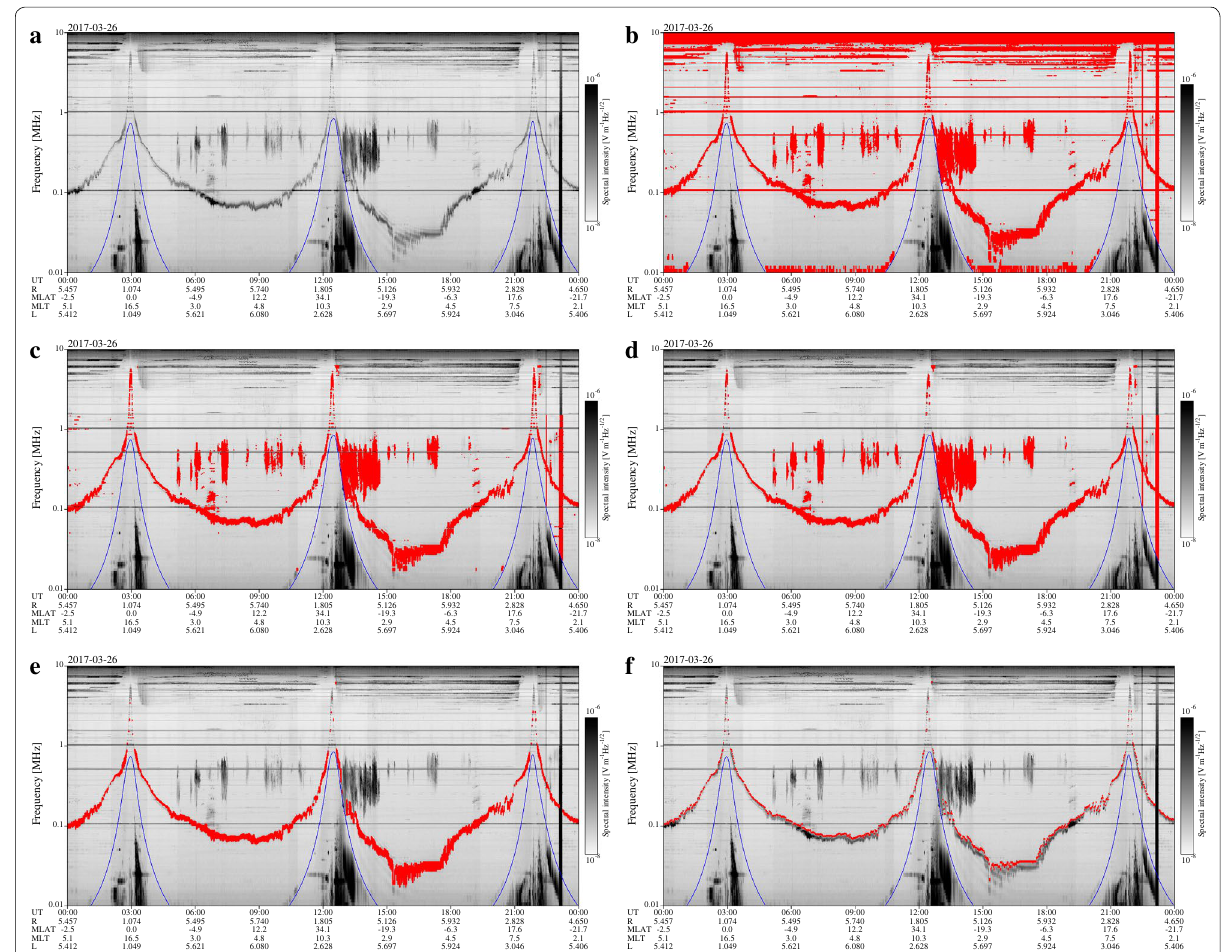
Fig. 7 Automatic determination of UHR frequency. a Spectrogram measured by HFA. b The emissions with an intensity greater than 4 Vm − 1 Hz − 1/2 are selected out as candidates of UHR frequency (red). c Known artificial noises are removed. d Median filter is applied. e The emis- sions with a bandwidth larger than 200 kHz are removed. f The upper limit frequency of the emissions. Blue curves indicate the electron cyclotron frequency from